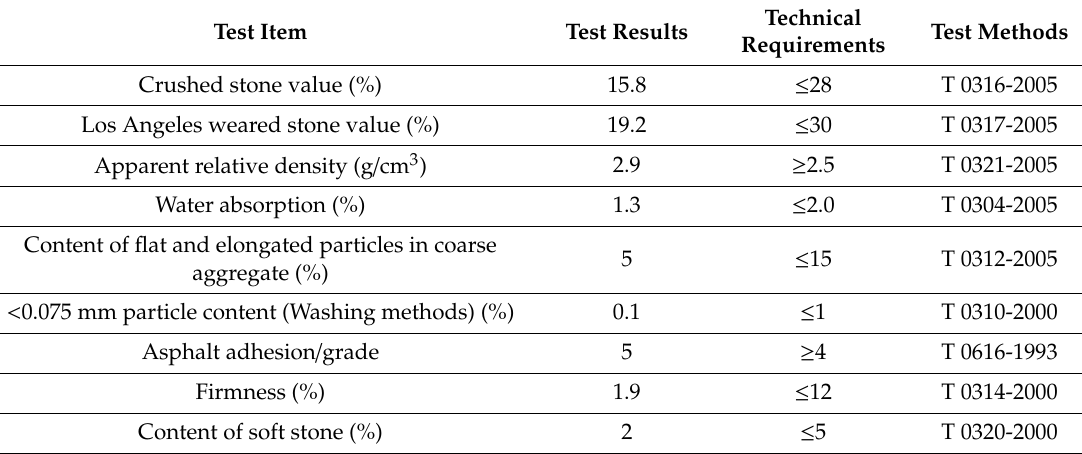
Table 2. Properties of aggregate basalt.